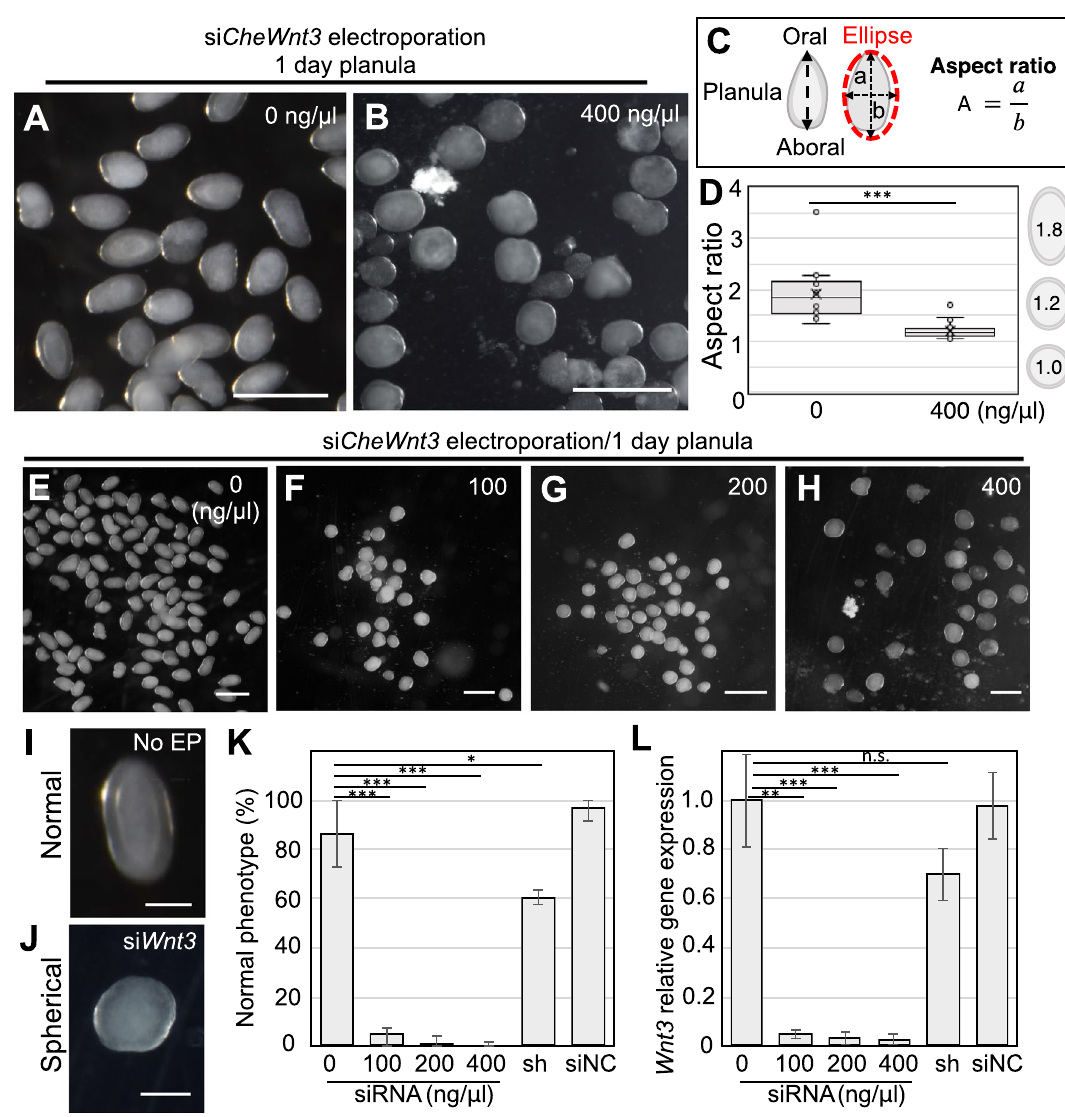
Figure 4. Phenotypes of Wnt3 knockdown with siRNA in Clytia fertilized eggs. ( A , B ) Typical phenotypes of Clytia 1-day planula. While morphologies of control planula (0 ng/µl) have an elongated oval-shape (A), those of CheWnt3 siRNA (400 ng/µl) are spherical in shape ( B ). ( C ) Schematic of ellipse approximation for planula morphology and calculation of the aspect ratio. The aspect ratio was calculated by dividing the long axis (a) by short axis (b). ( D ) Boxplots showing the aspect ratio of the 1-day planula. Center lines show the medians; x’s denote the mean values; box limits indicate the 25th and 75th percentiles; whiskers show maximum and minimum values; inner points and outliers are represented by circles. Number of examined planula: 0 ng/ µl, n = 127; 400 ng/µl. n = 25, ***p < 0.001. ( E – H ) Phenotypes of 1-day planula after siRNA targeting CheWnt3 electroporation (0, 100, 200, and 400 ng/µl si CheWnt3 ). ( I and J ) For morphology quantification, we classified planula phenotypes into two categories: elongated oval shape as “normal” and spherical (circle) shape as “spherical”. ( K ) Bar plots show the percentage of normal phenotypes across four different siRNA doses as well as planulae treated with shRNA and siNC, a siRNA universal negative control. Percentages are the mean value and error bars indicate standard deviation. Numbers of examined planula: 0 ng/µl, n = 127; 100 ng/µl, n = 75; 200 ng/ µl, n = 86; 400 ng/µl, n = 95. shRNA 400 ng/μl, n = 288; siNC 400 ng/μl, n = 45. Experiments were repeated three times. Error bars: maximum and minimum values. p-values: 100 ng/μl, p = 0.000599; 200 ng/μl, p = 0.000438; 400 ng/μl, p = 0.000402; 400 ng/μl of shRNA, p = 0.031928; 400 ng/μl of siNC, p = 0.283359. *p < 0.05, ***p < 0.001. ( L ) Quantification of CheWnt3 mRNA levels of 1-day planula by RT-qPCR. CheEF1alpha was used as an internal control. Bar heights represent the mean value. CheWnt3 expression levels are standardized relative to the control (0 ng/µl). Error bars: standard deviation. p-values: 100 ng/μl, p = 0.00799; 200 ng/μl, p = 0.000754; 400 ng/μl, p = 0.000733; 400 ng/μl of shRNA, p = 0.095403; 400 ng/μl of siNC, p = 0.900264. **p < 0.01, ***p < 0.001. n.s., not significant. Experiments were performed in triplicate and repeated at least three times. Scale bars: ( A, B, E–H ) 400 µm, ( I, J ) 100